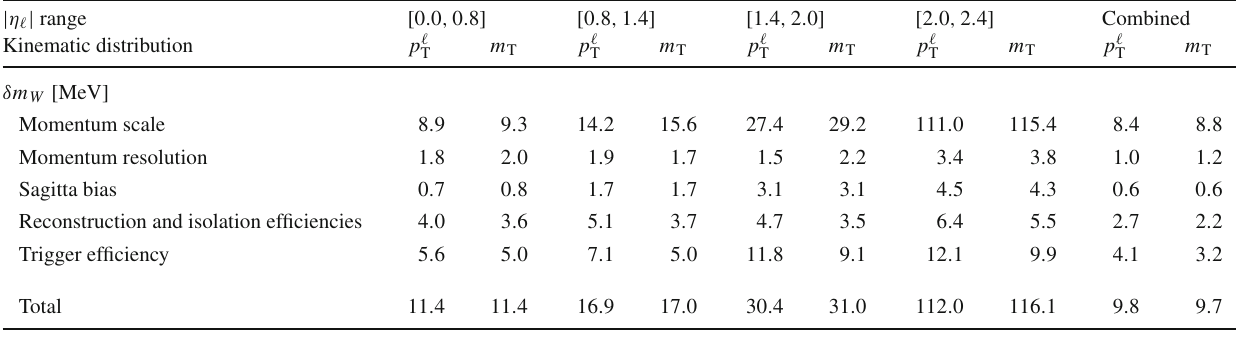
momentum-scale uncertainties include the effects of both the momen- tum scale and linearity corrections. Combined uncertainties are evalu- ated as described in Sect. 2.2